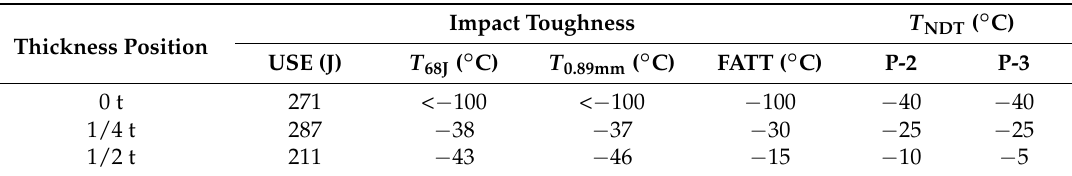
Table 2. Results of Charpy impact and Pellini drop weight tests.